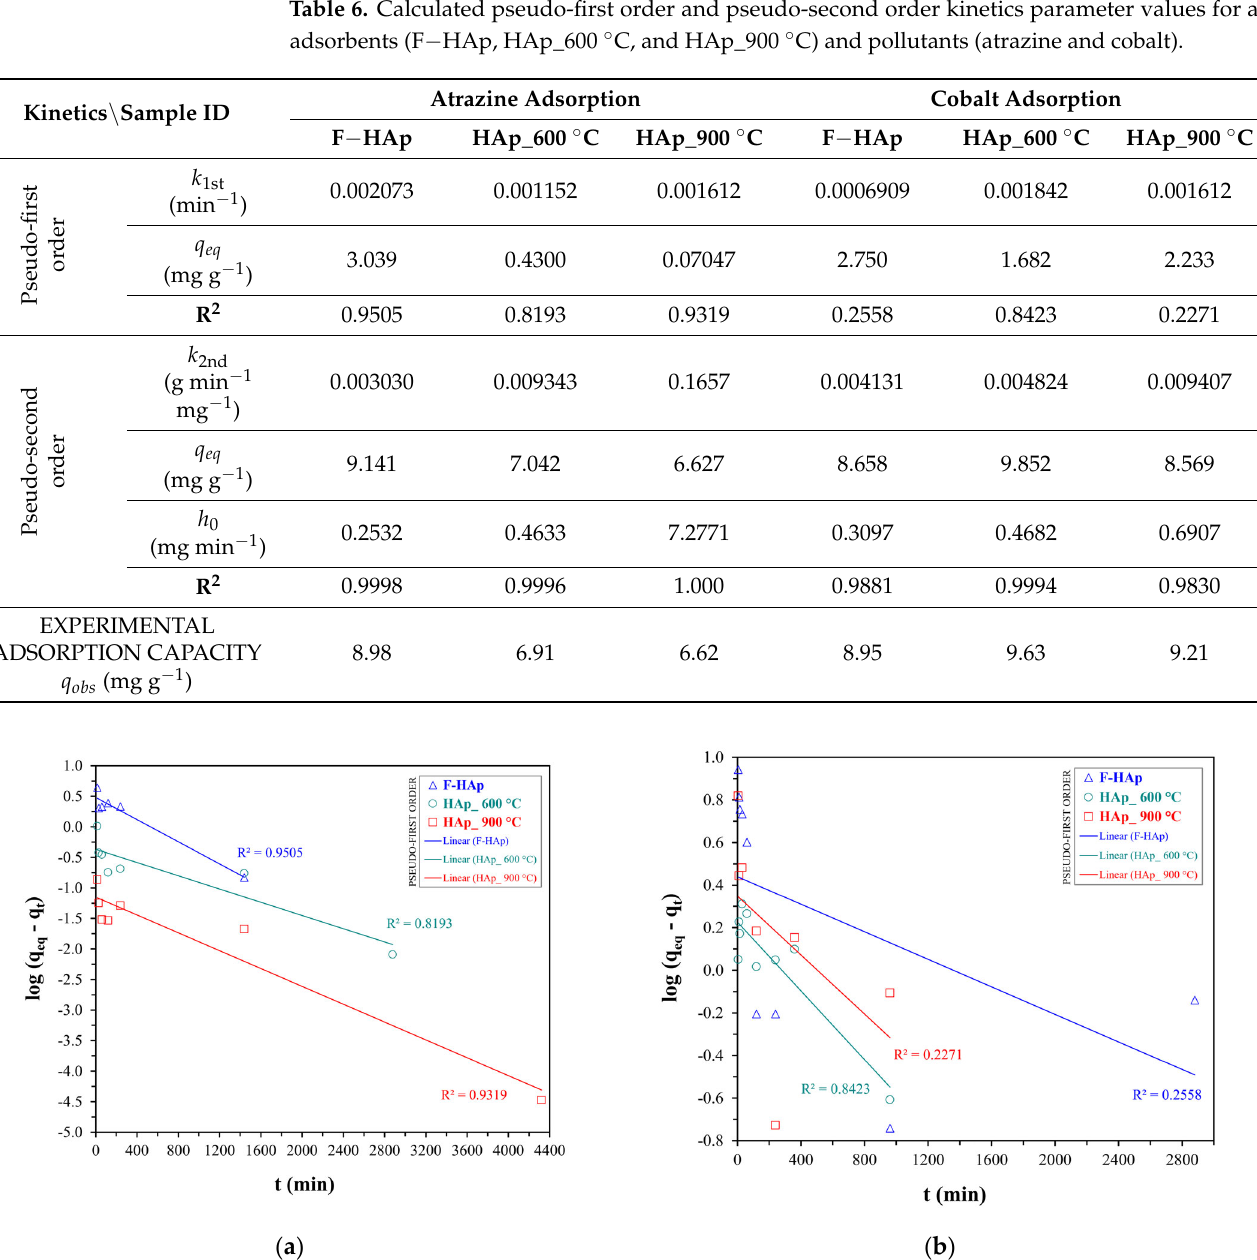
Table 6. Calculated pseudo-first order and pseudo-second order kinetics parameter values for all